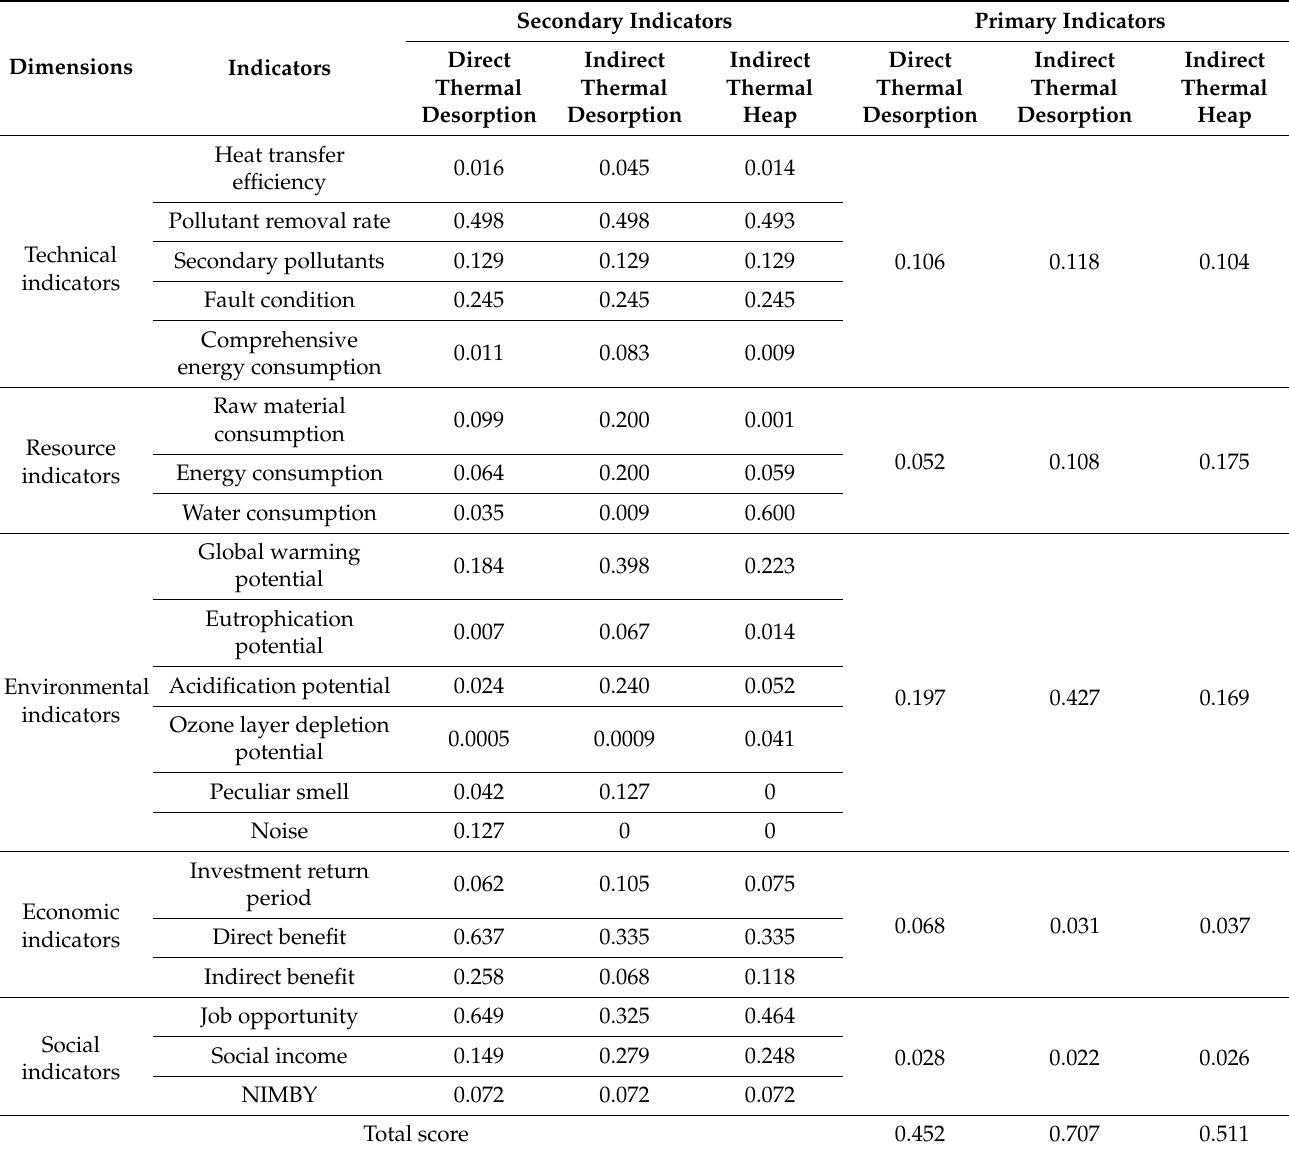
Table 13. Comparison of primary and secondary indicators for the three ex situ thermal desorption